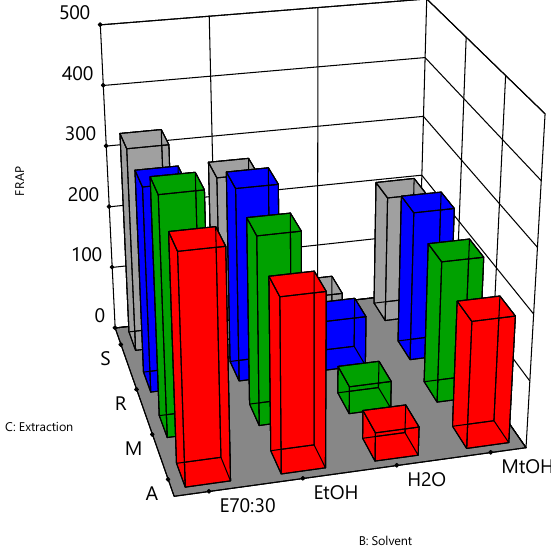
Figure 6. Interaction effects of extraction solvent and extraction method on the FRAP antioxidant activity for bee pollen samples. FRAP values were expressed as μ mol Fe +2 equivalent per gram pollen, B: extraction solvent (70% ethanol:30% = E70:30, ethanol = EtOH, water = H 2 O, and methanol = MtOH) and C: extraction process (agitation = A, maceration = M, reflux = R, and sonication = S).